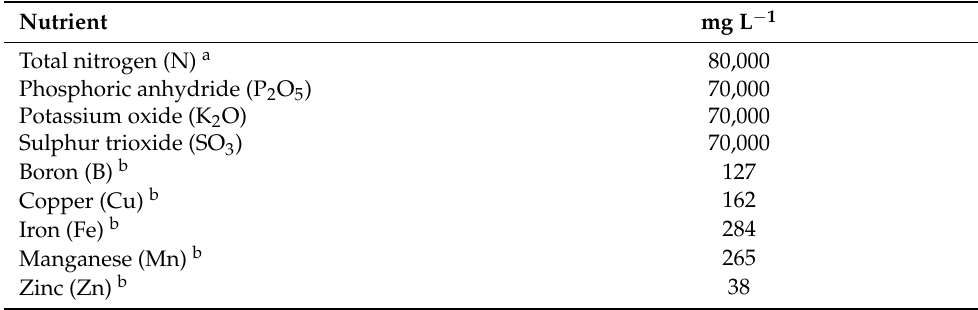
Table 4. Composition of the applied foliar